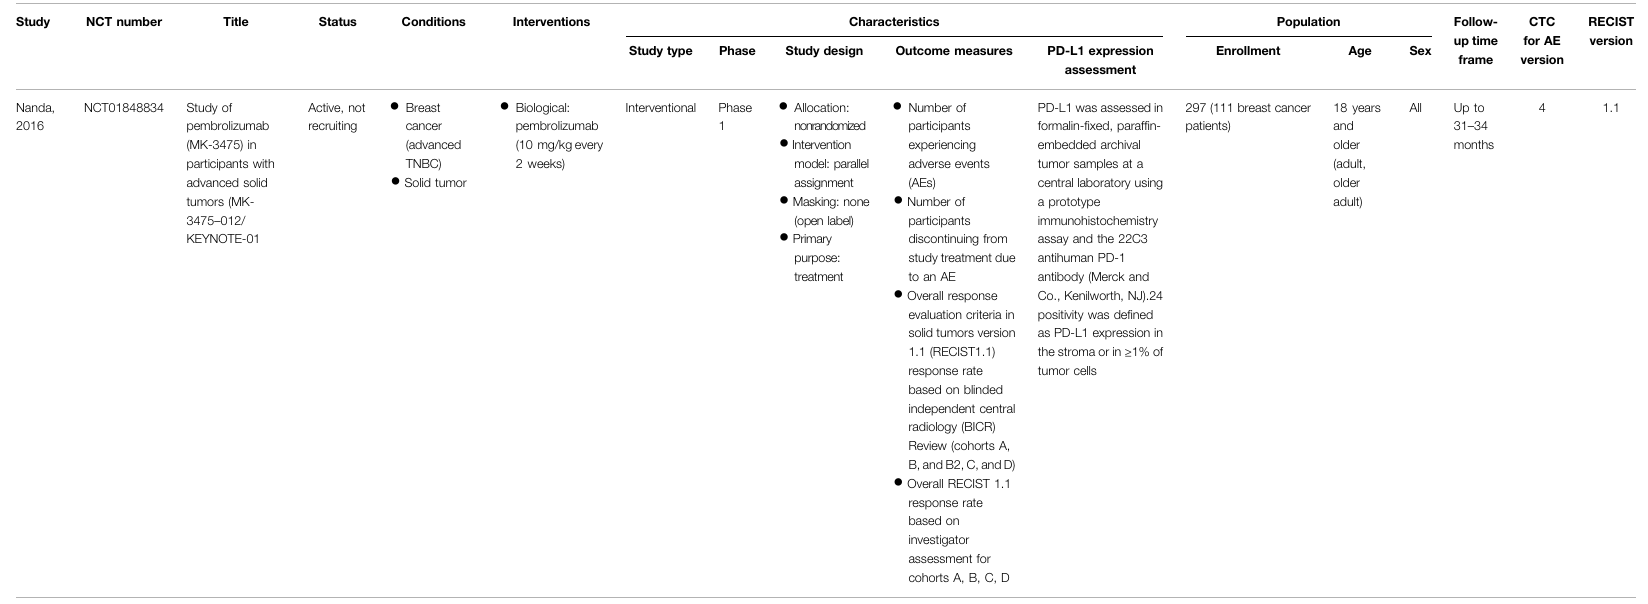
TABLE 1 | ( Continued ) Characteristics of clinical trials included for